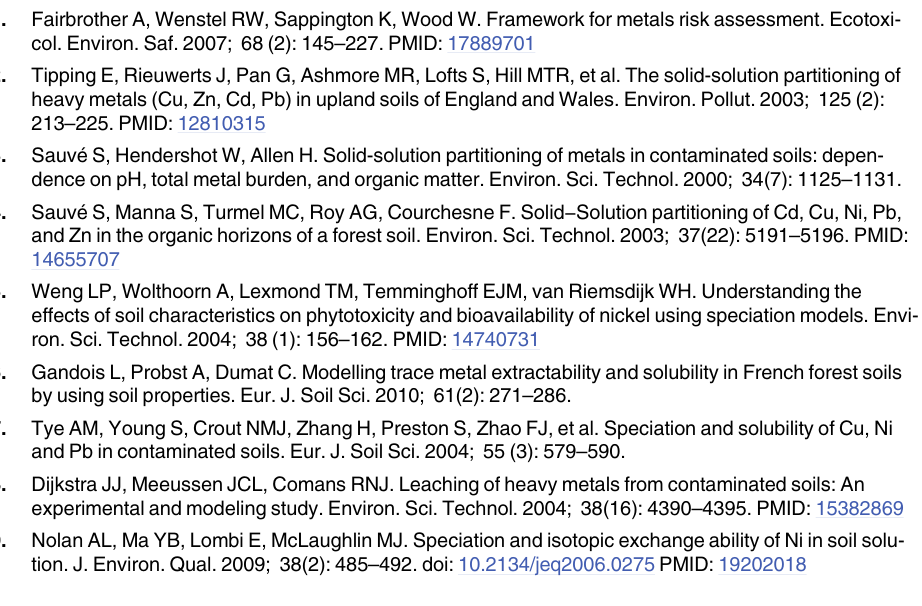
S1 Table. Correlation matrix (Pearson correlation cofficient) between lgNi concentration dis in leached soil pore water and lgNi together with soil properties (n = 97) (Ni and Ni tot tot dis represented total Ni concentration in soil and the soluble Ni concentration in soil pore water, respectively). concentration S2 Table. Correlation matrix (Pearson correlation cofficient) between lgNi dis in soil together with soil properties (n = 102) (Ni in unleached soil pore water and lgNi tot tot and Ni represented total Ni concentration in soil and the soluble Ni concentration in soil dis pore water, respectively). concentration in soil pore water and lgNi S3 Table. Multiple regressions between lgNi dis tot in soil together with soil properties (Ni and Ni represented total Ni concentration in tot dis soil and the soluble Ni concentration in soil pore water,